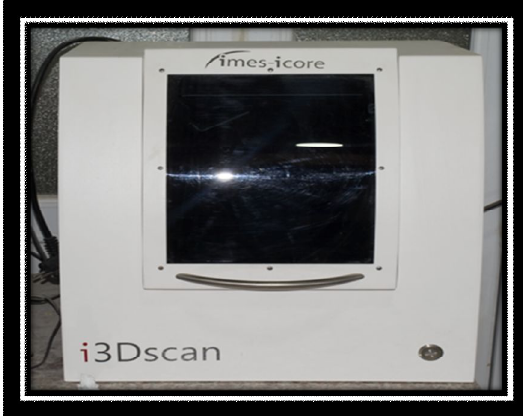
Figure 4: 3D scan of Imes-icor